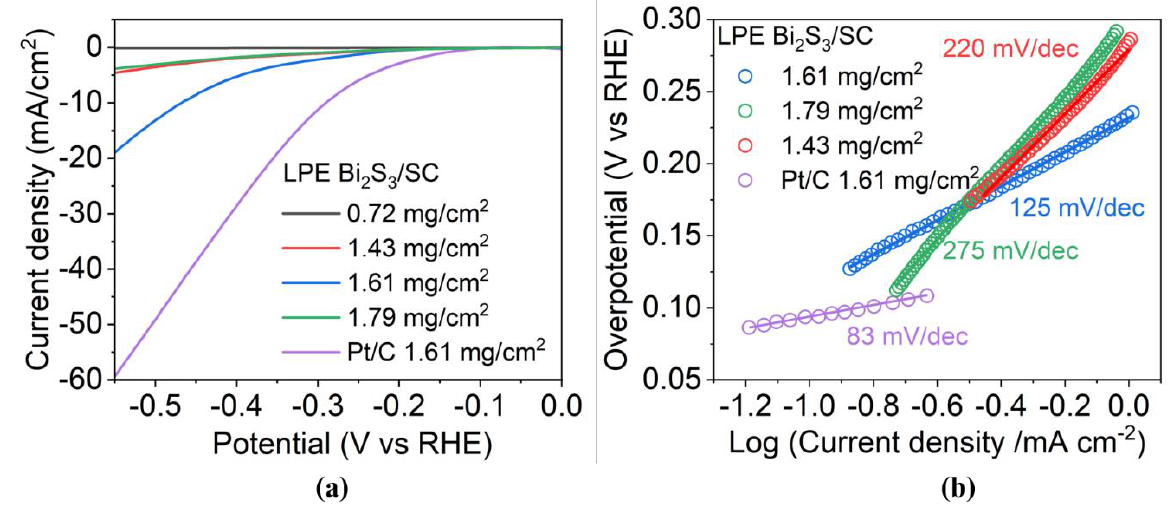
Figure 5. ( a ) LSV curves (scan rate 10 mV/s) measured in neutral condition (Na 2 SO 4 0.5 M) using different loadings of LPE Bi 2 S 3 /SC. Pt/C HER activity is reported as a reference; ( b ) Tafel plots from LSV curves reported in Figure 5a. Table 1. Comparison of electrocatalytic HER performance for different Bi 2 S 3 electrocatalysts. Catalysts